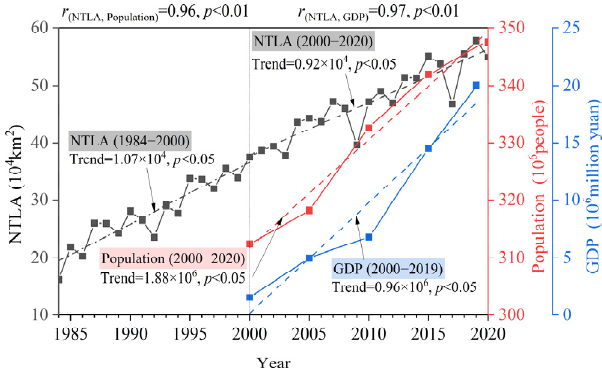
Figure 14. Slope and correlation in NTLA, population, and GDP.